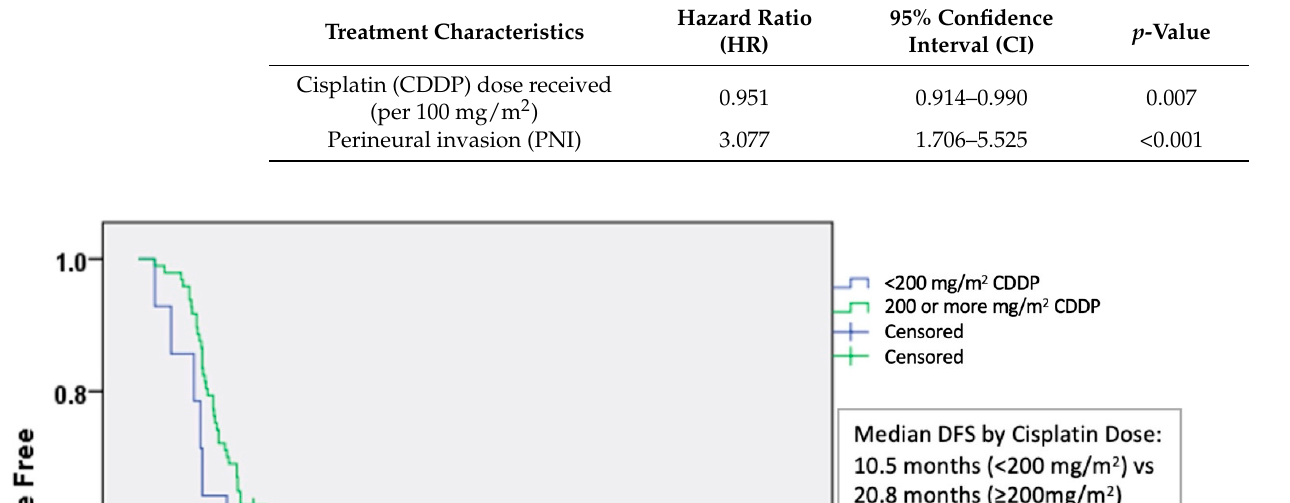
Table 2. Multivariate disease-free survival (DFS).